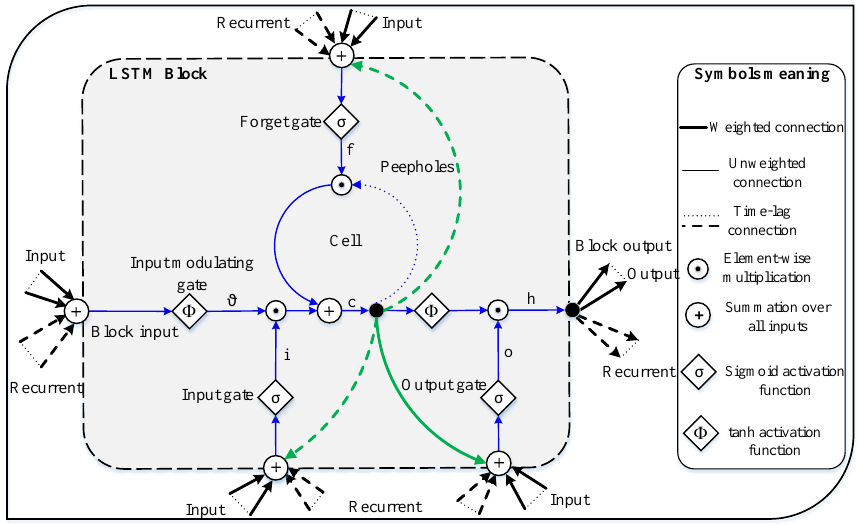
Figure 2. Long short-term memory (LSTM) block architecture